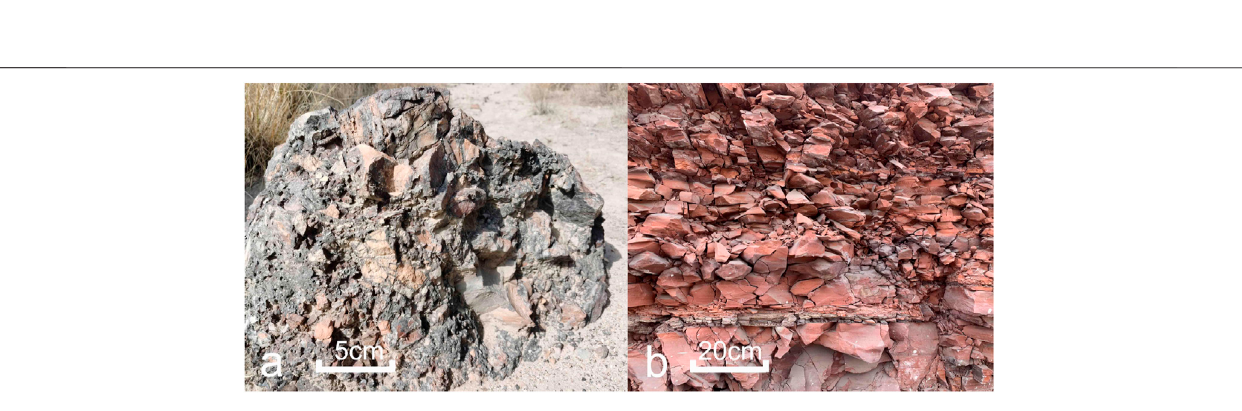
FIGURE 2 | (A) Burnt rock block and (B)